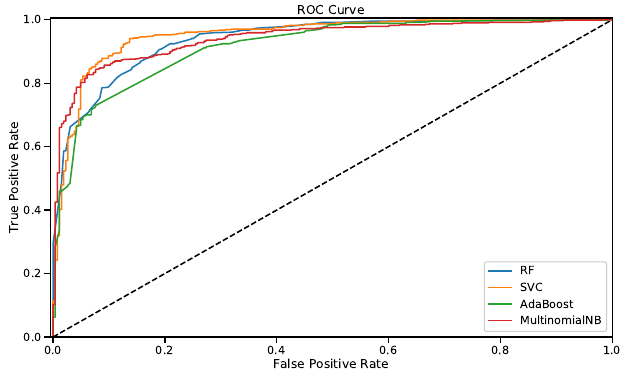
Figure 2. Visualization of the ROC curves of the classical machine-learning algorithms using TF–IDF